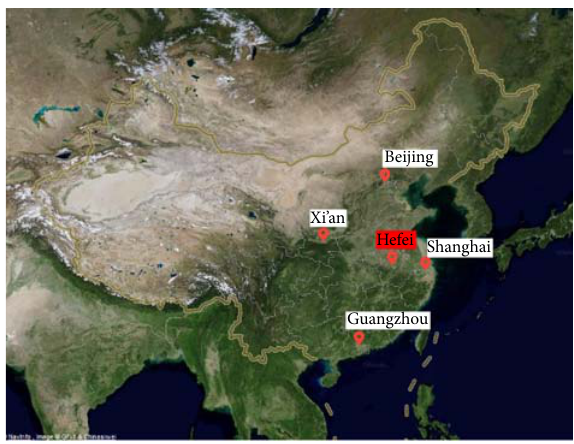
Figure 1: Location of Hefei city, as marked by the red rectangle.